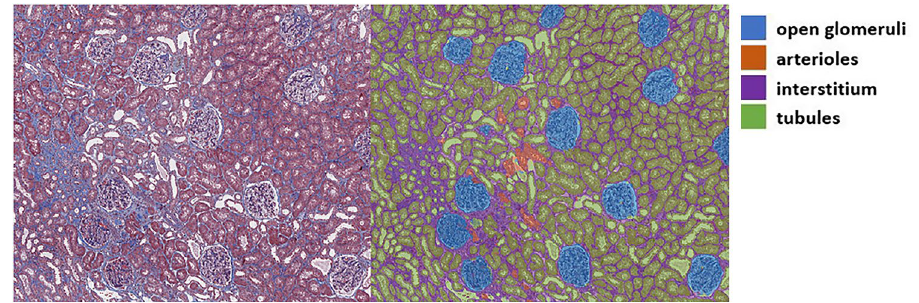
Figure 4. An example of a trichrome-stained image (left) and an automatically segmented image from our trained deep learning model (right).